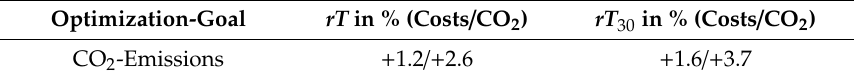
Table 5. Optimization results of scenario 3 in comparison to the results with standard